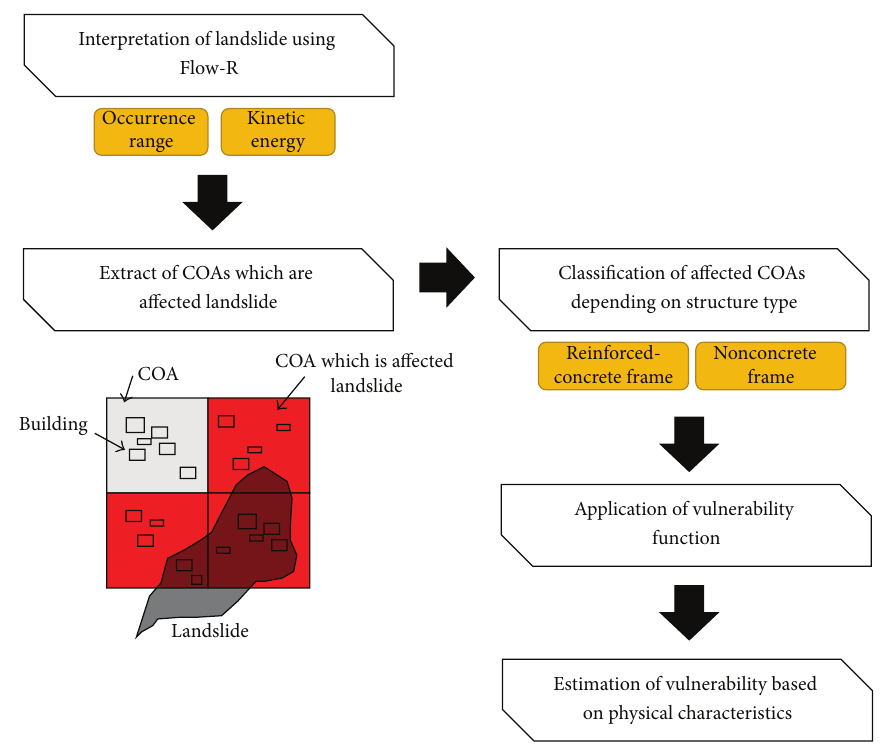
Figure 3: Procedure of physical vulnerability assessment.